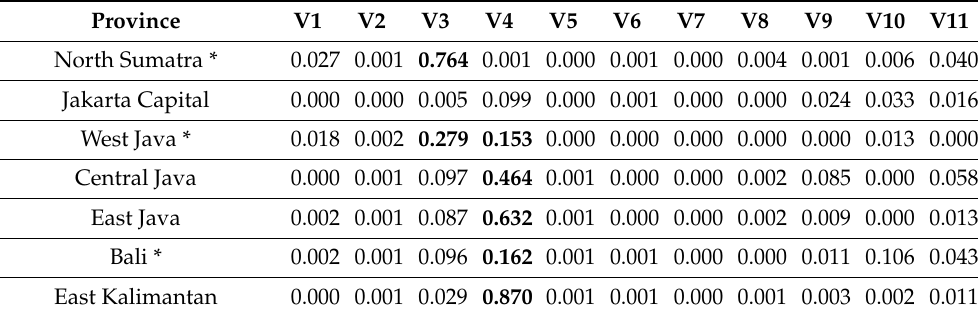
Table 4. Normalized and weighted data of the vulnerability